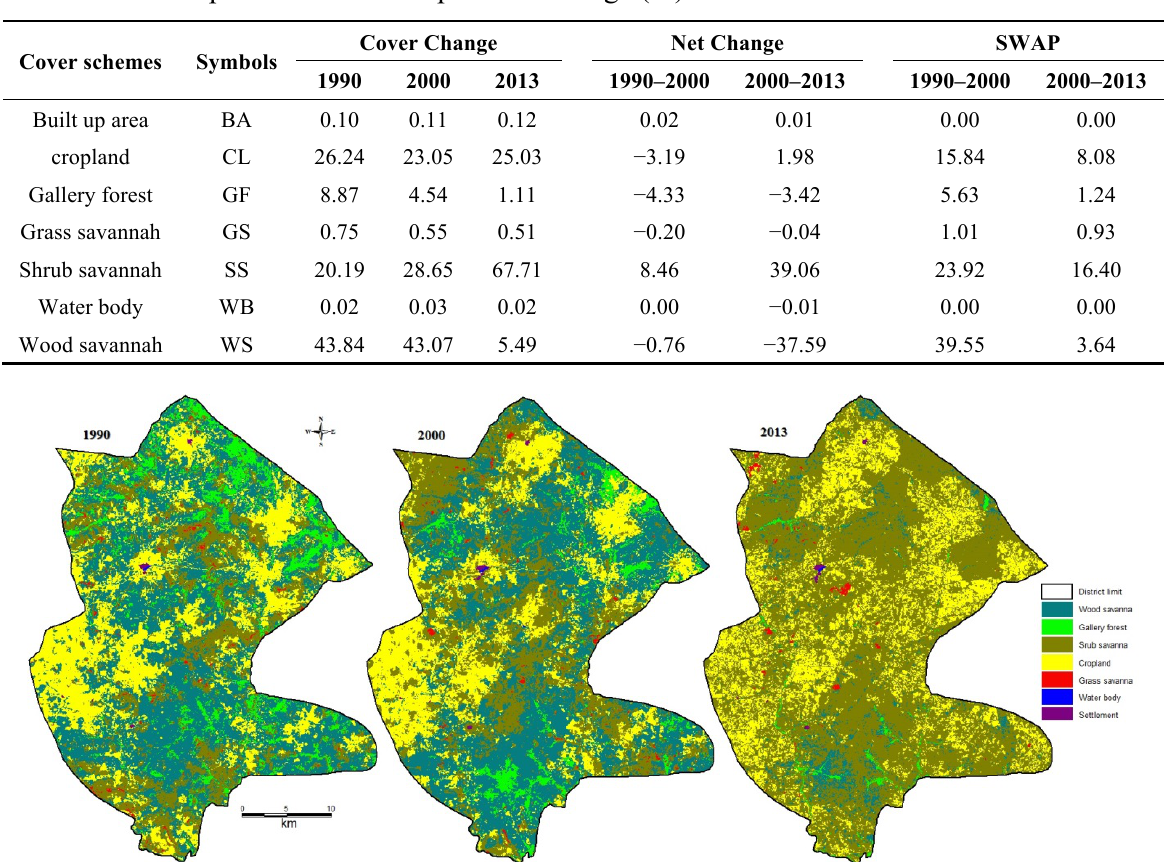
Table 4. Proportions of landscape cover change (%) in Cassou between 1990 and 2013.